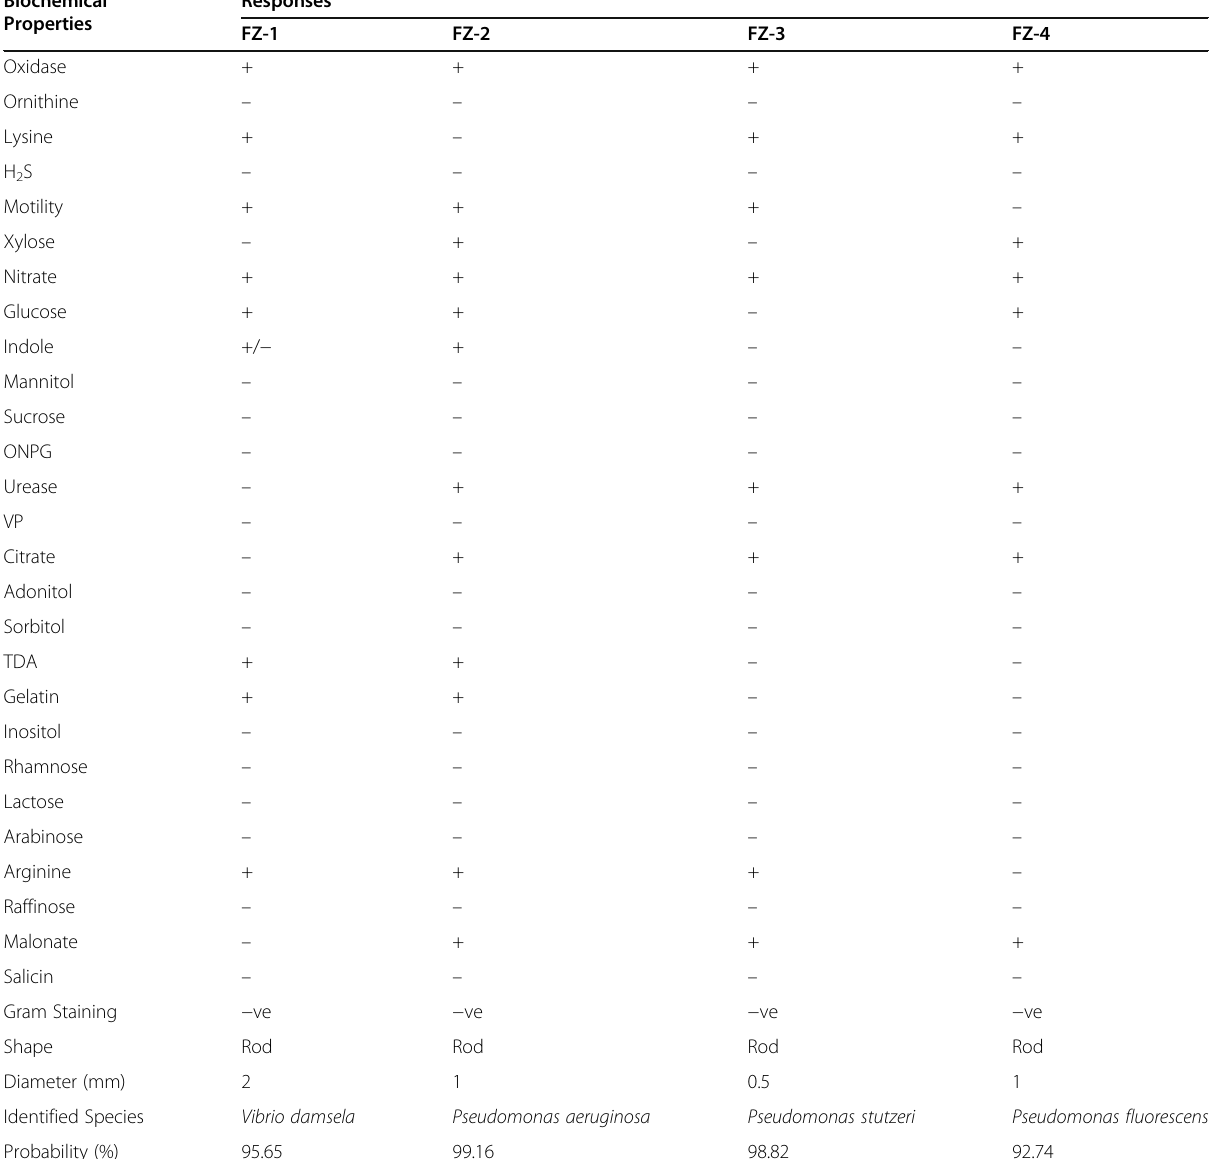
Table 2 Biochemical test of isolated bacteria Biochemical